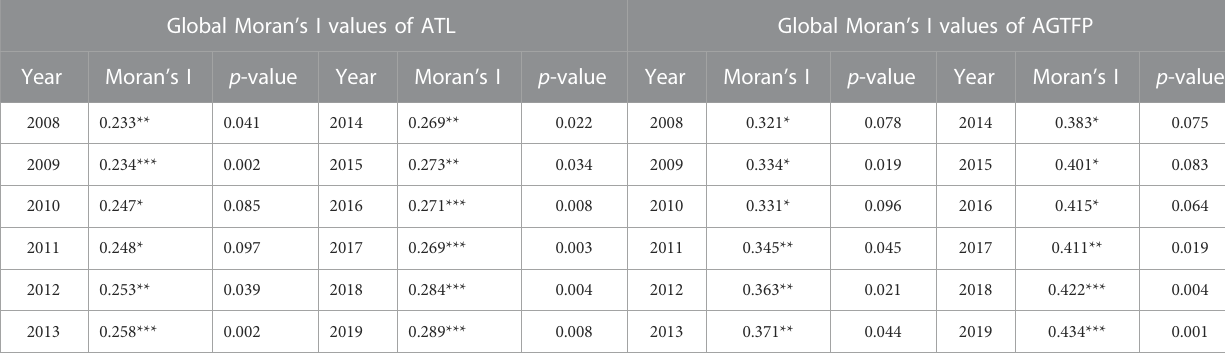
TABLE 6 Global Moran ’ s I values of ATL and AGTFP 2008 – 2019.